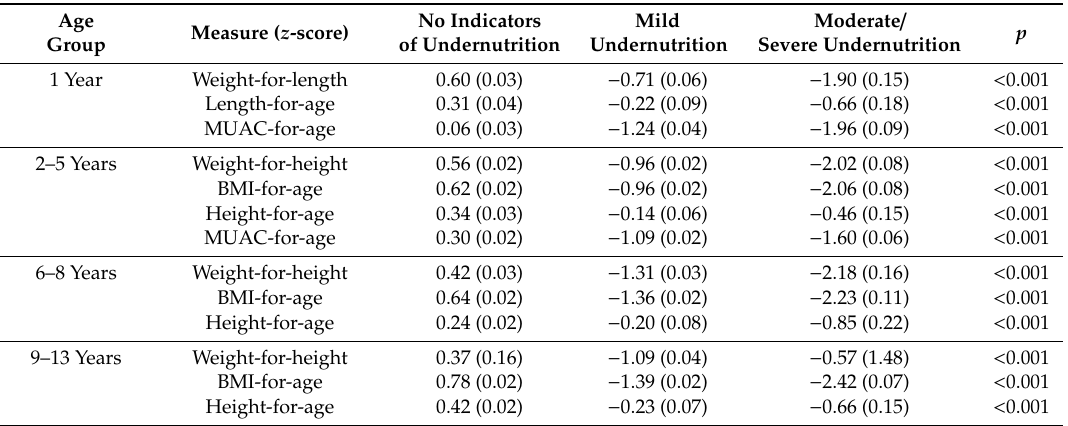
Table 5. Di ff erences in mean z -scores for growth metrics by undernutrition category and age groups in US children from NHANES 2005–2014 data ( n =